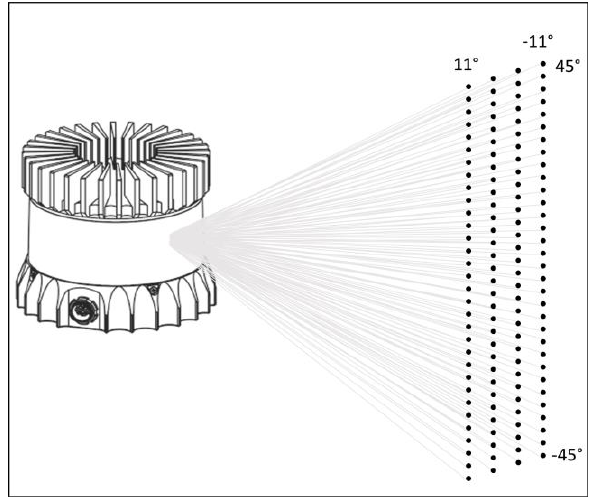
Figure 3. The OS0-128 sensor with the 128 beams emitted simultaneously. The rotation rate and the horizontal resolution are configured by the operator. The rotation rate can be tuned to 10 or 20 Hz, and the horizontal resolution can be set to 1024 or 2048 ticks (number of rotational steps in a single sensor turn). Figure 4 shows a point cloud obtained in a single turn with OS0-128 with a frequency of 10 Hz and a horizontal resolution of 1024 ticks. Detailed information on the OS0-128 sensor and the internal IMU are presented in Table 1.